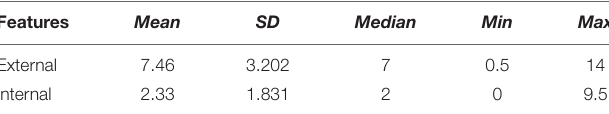
TABLE 4 | Descriptive statistics for external and internal facial features of culprits reported by participants. Features